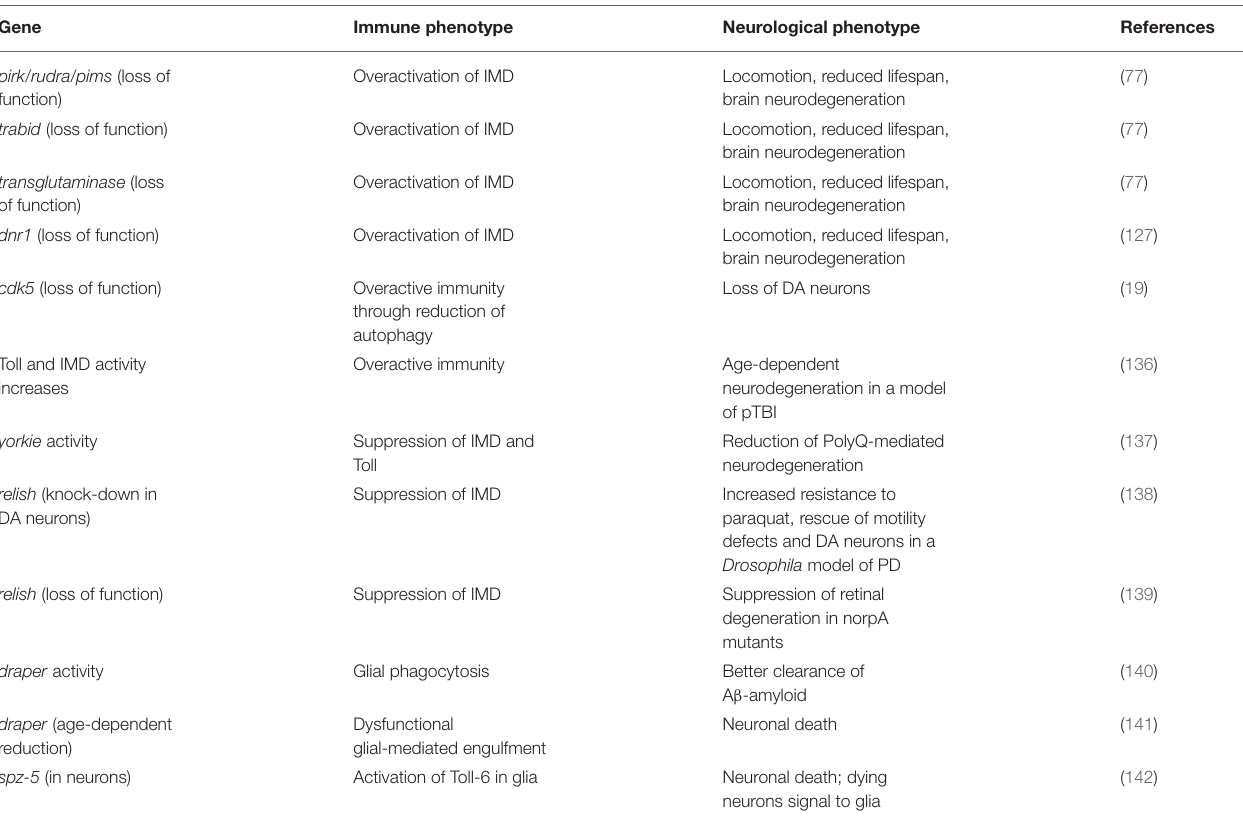
TABLE 1 | Summary of papers at the junction of immunity and neurodegeneration in Drosophila